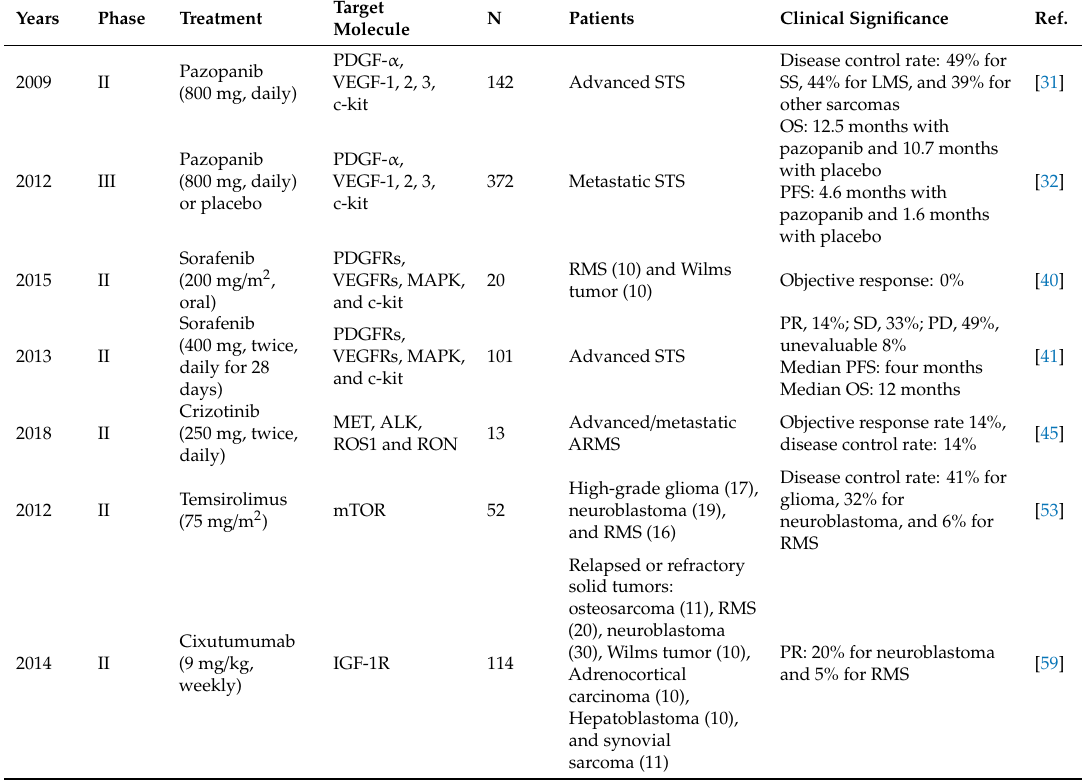
Table 2. Clinical trials of molecular targeting agents for